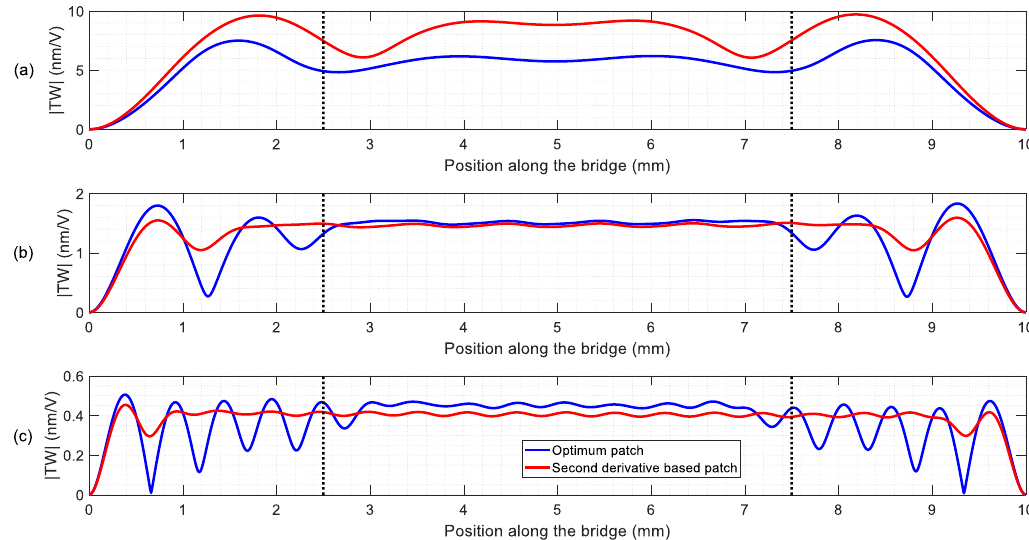
Figure 4. Resultant envelopes from the simulations with optimal patches and patches deduced from the approach based on the zeros of the second derivative in the ( a ) LF range, ( b ) IF range and ( c ) HF range. The dotted vertical lines indicate a centred 50% of the length. Table 3. Figures of merit deduced from the TW envelopes of Figure 4 for the two types of patches under study for the three frequencies considered. The values for the design parameters l 1 and l 2 are also given.